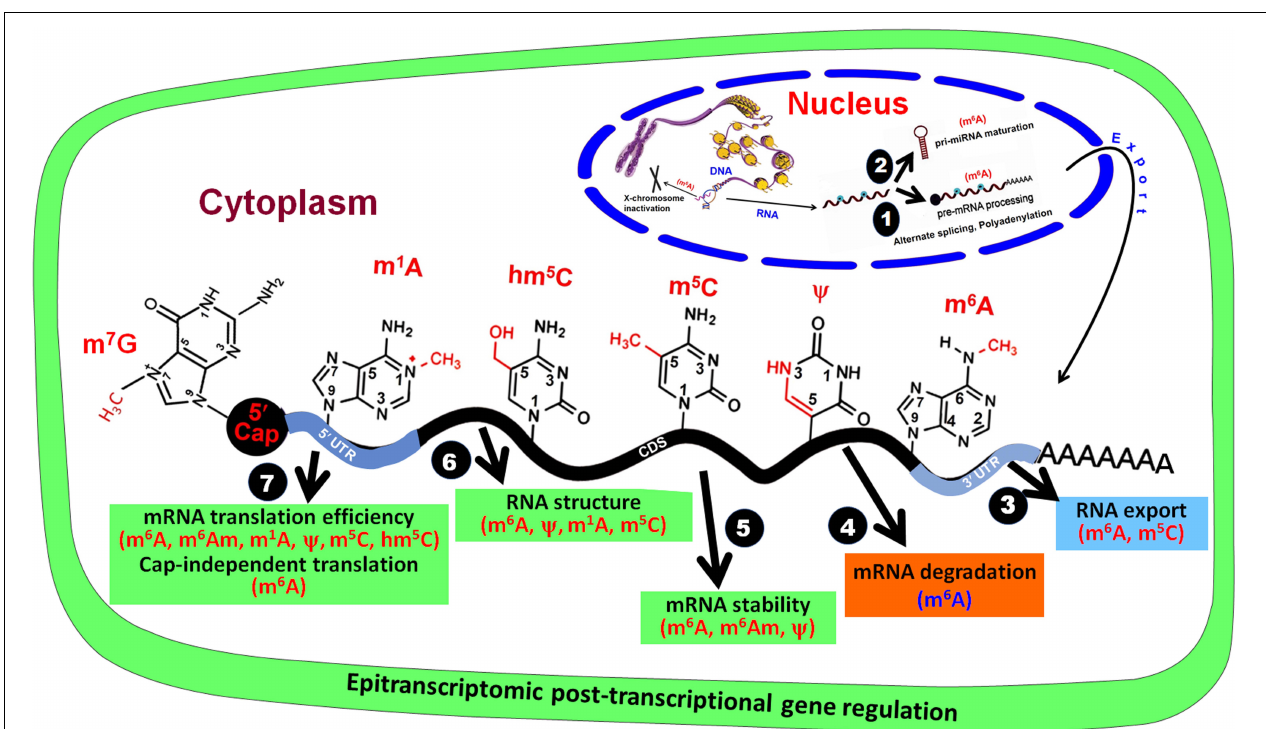
FIGURE 2 | Base modifications in mRNA affect post-transcriptional gene regulation. In the nucleus, RNA base modifications affect (1) pre-mRNA processing and (2) pri-miRNA maturation, and (3) their export from the nucleus. In the cytoplasm, RNA base modifications regulate (4) mRNA degradation, (5) mRNA stability, (6) RNA structure, and (7) mRNA translation